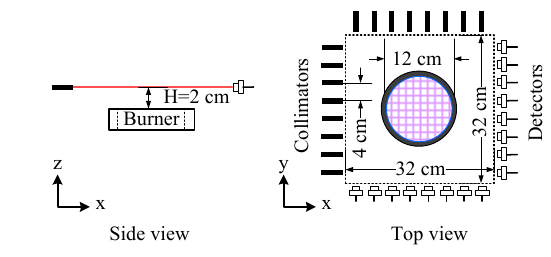
Figure 10. Schematic of the burner.